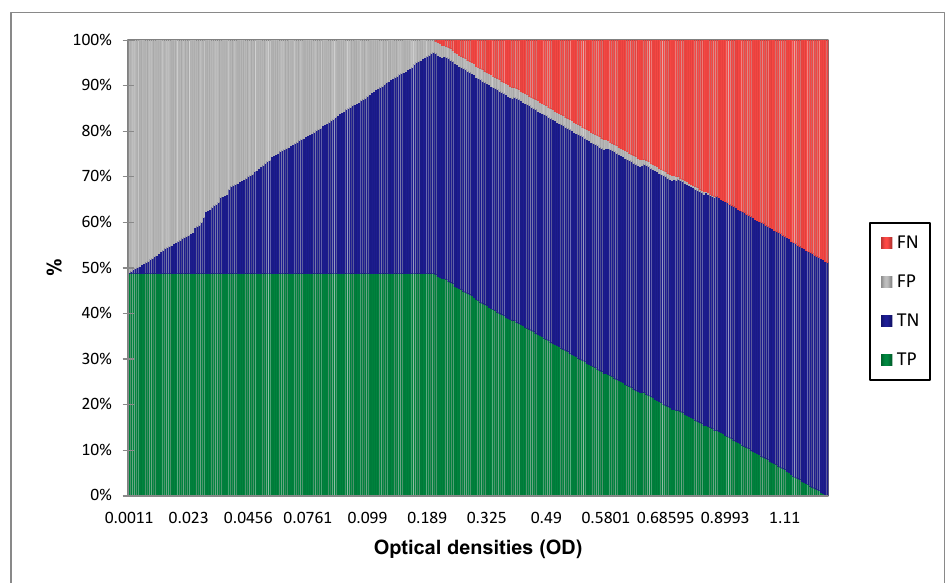
Figure 2. Sensitivity, specificity, TP, TN, FP, and FN per OD value.